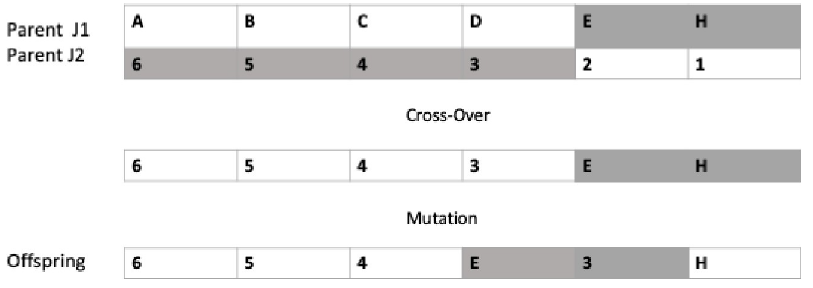
Fig 11. Offspring representation for the genetic algorithm mutation and crossover